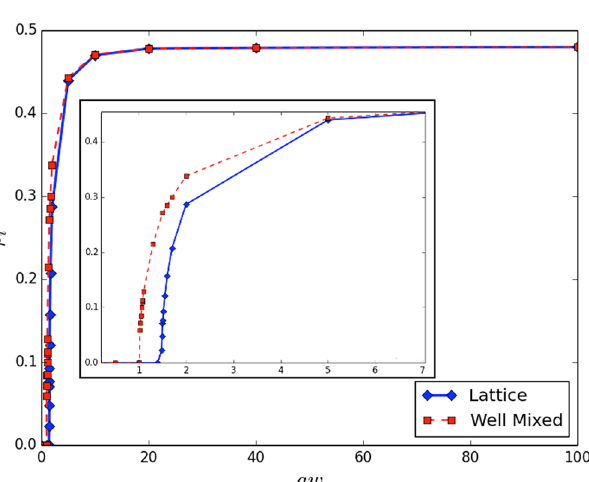
Figure 3. Density of innovators varying the award factor in both configurations, i.e. lattice and well